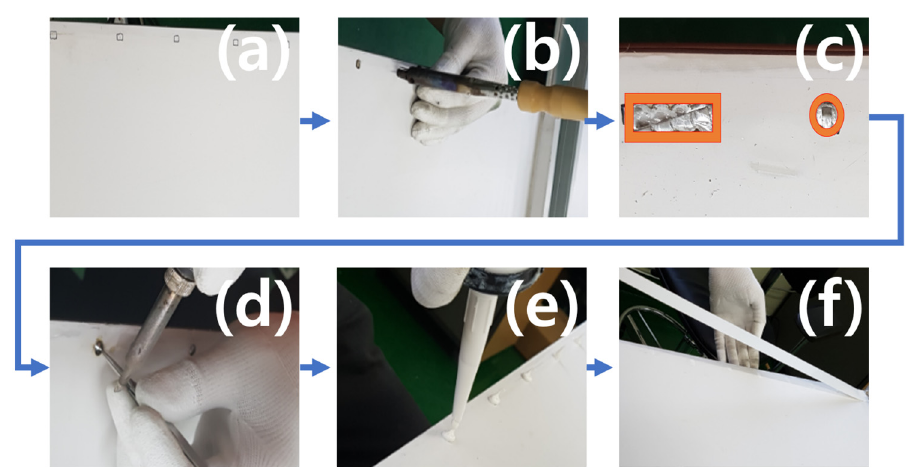
Figure 6. RSB hotspot module recovery process diagram by on-site recovery technology. ( a ) punching position indication, ( b ) removing the back sheet and EVA in the repair area, ( c ) removing the EVA around the busbar and ribbon, ( d ) re-soldering after application of flux, ( e ) applying silicone resin and sealant, ( f ) finishing with back sheet tape.